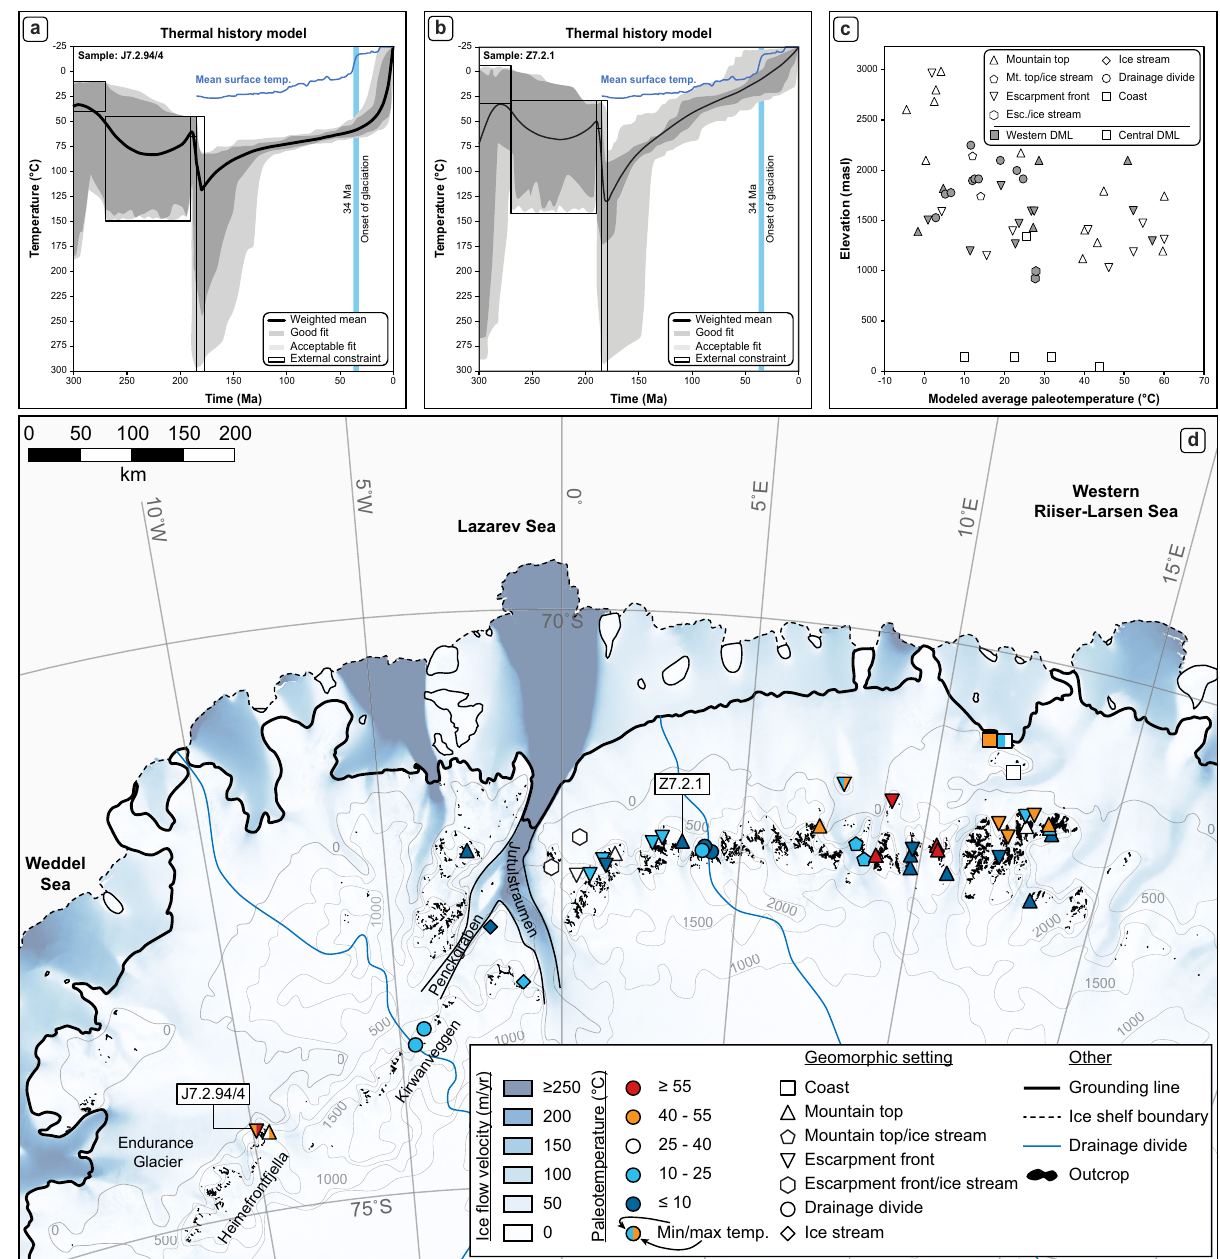
Fig. 2 Outcome of thermal history models. a , b Thermal history models exempli fi ed by samples from wDML. External modeling constraints are described in detail in Supplementary Notes 1. a Large difference between the mean annual surface temperature curve 66 and the modeled temperatures indicate substantial erosional cooling. b The similarity between the mean annual surface temperature 66 at the onset of the glaciation suggests that the sample experienced (near-)surface conditions already at the onset of the glaciation, and that the cooling is mainly attributed to climatic cooling. c Modeled average paleotemperatures plotted against elevation with respect to geomorphic location in western and central DML. Unweighted average paleotemperatures generally increase with decreasing elevation. The coast-proximal samples from Schirmacheroasen are exceptions, where large variations in paleotemperature (c. 10 – 45 °C) is recorded over a small range in elevations (100 m). d Recorded paleotemperatures of the samples. Together with samples from high elevations, samples close to the drainage divides generally record low modeled paleotemperatures at 34 Ma. For samples where minimum and maximum paleotemperatures are reported, the temperatures are obtained from adjacent samples. Map features 47,62 – 64 were obtained from the Quantarctica package 65